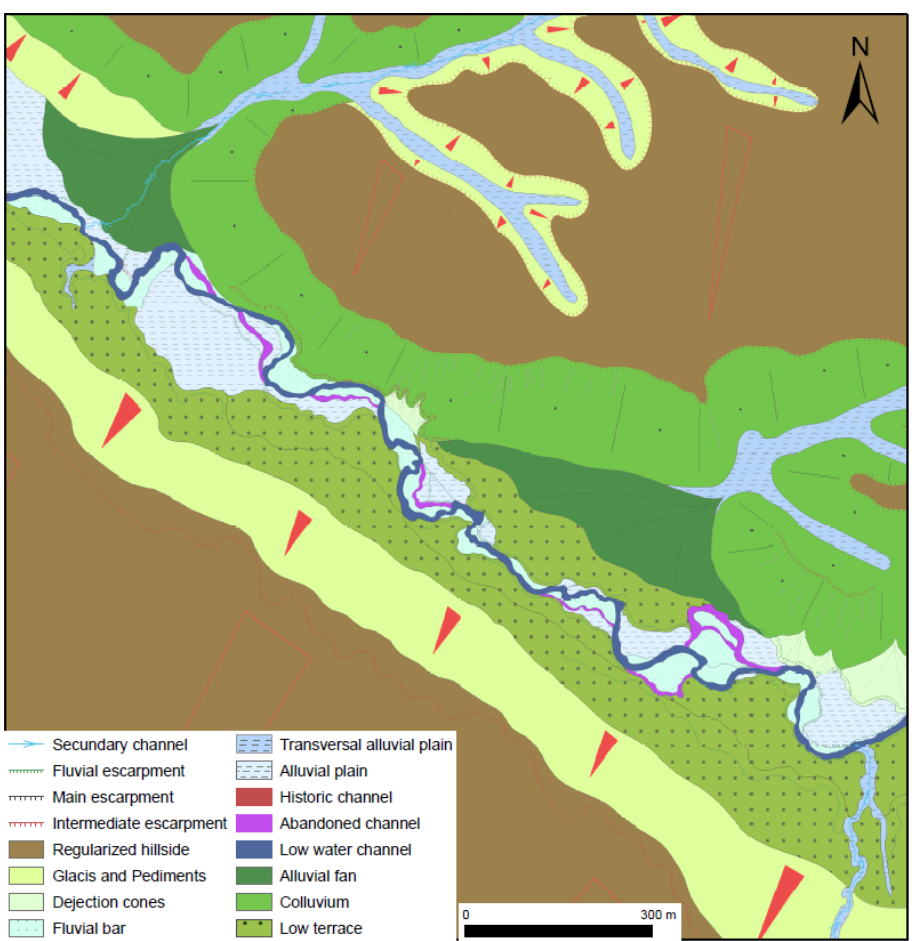
Figure 7. Geomorphological mapping of Section 2 of the stream studied. Through channel analyses, it was recognized that abandoned channels are mainly located at the left bank of the current low-water channel, which were reclassified as Type C flows, as can be seen in Figure 8.